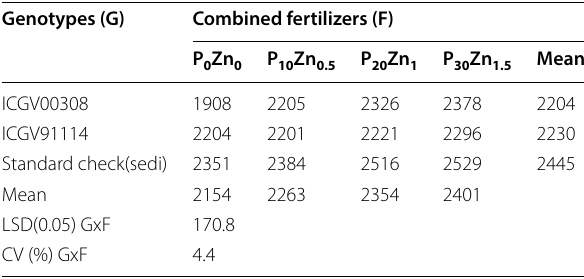
Table 6 Seed yield (kg/ha) as affected by interaction of genotypes and PZn